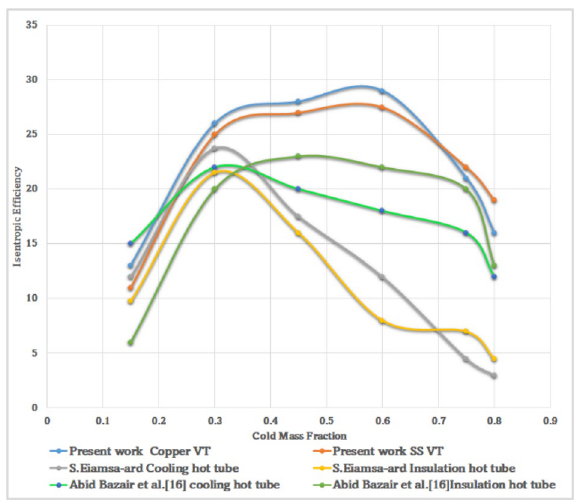
Figure 65. CMF vs isentropic efficiency.